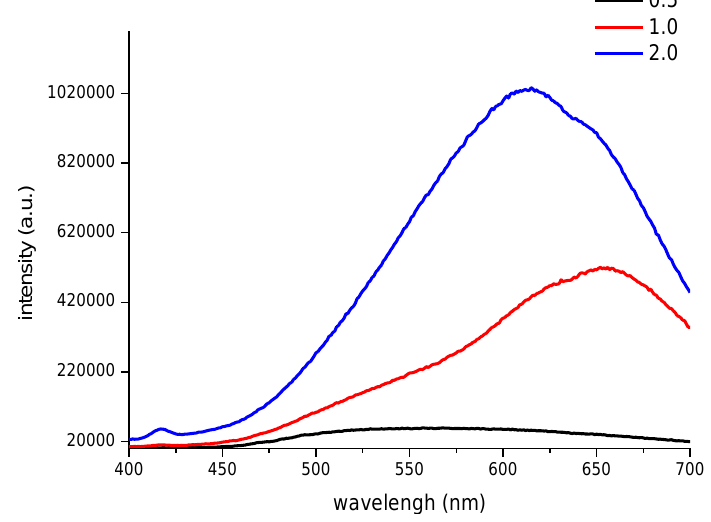
Figure 3. The PL spectra of the CNF/CdS nanocomposites with different –COOH/Cd 2+ ratios (excitation wavelength 365 nm).